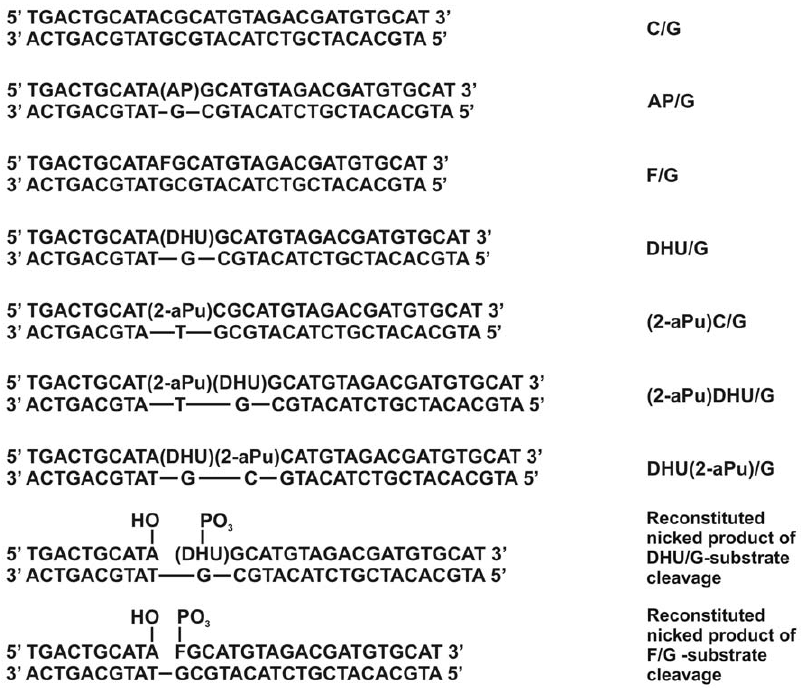
Figure 1. Schematic presentation of various DNA duplexes used in this study.